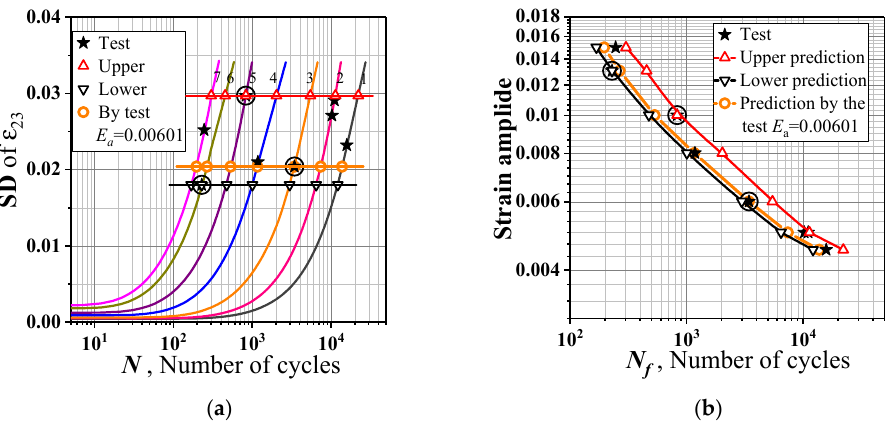
N E ; ( b ) predicted fatigue–life curves and their comparison with mining point sequences predict ( , ) ˆ ( ) E ε : ( a ) determining upper and lower of critical value and deter- Figure 10. Verification of FIP Figure 10. Verification of FIP ˆ ε 23 ( E a ) : ( a ) determining upper and lower of critical value and de- f a 23 a